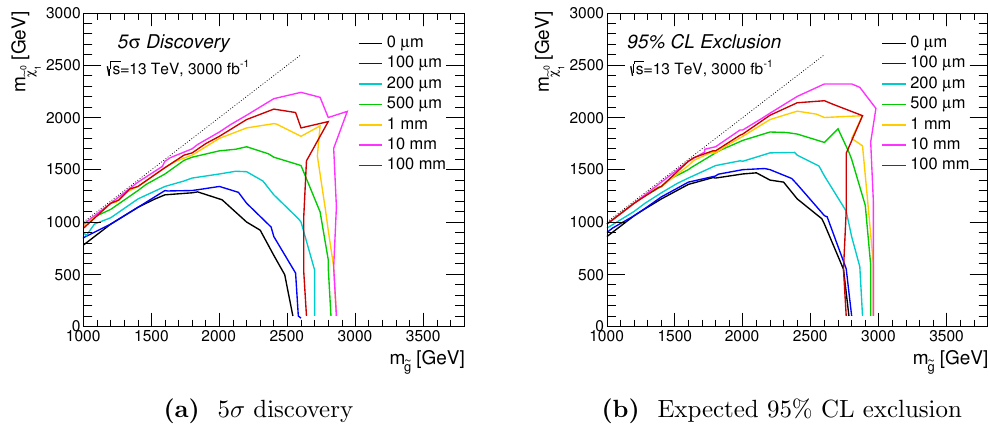
Figure 13. Same as in (cid:12)gure 11, but for an integrated luminosity of 3000 fb (cid:0) 1